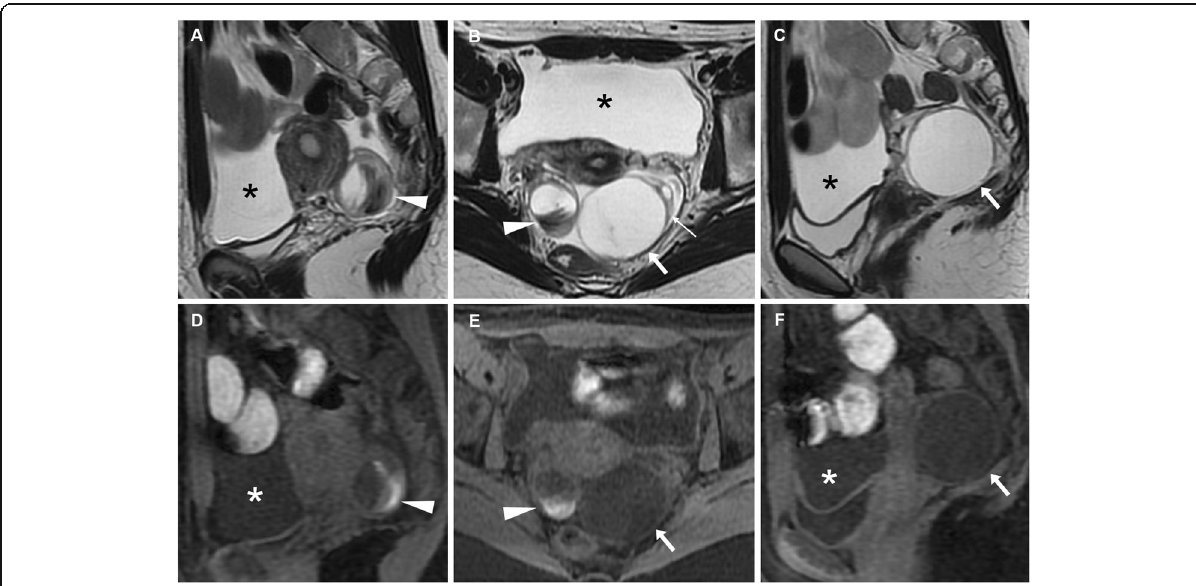
Fig. 7 Haemorrhagic corpus luteum and functional cyst in a 15-year-old woman with pelvic pain. Multiplanar T2-weighted ( a – c ) and precontrast fat-suppressed T1-weighted ( d – f ) images showed a right adnexal cyst (arrowheads) with internal fluid-fluid level and a bloody dependent component, T2-hypointense and T1-hyperintense. Contralaterally, a well-marginated unilocular cystic lesion of the left ovary (arrows) shows thin walls and homogeneous fluid-like signal intensity. Note the compressed ovarian parenchyma along the lateral edge of the cyst (thin arrow in b ) and pelvic peritoneal effusion